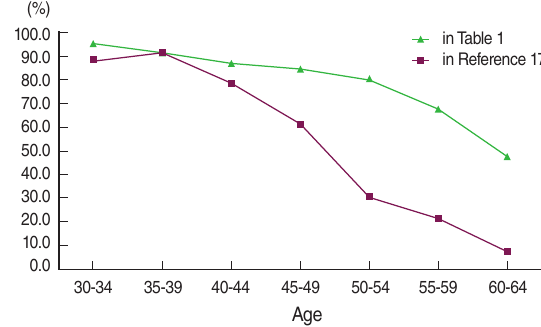
Figure 1. Curves of proportion of dense breast by age groups.